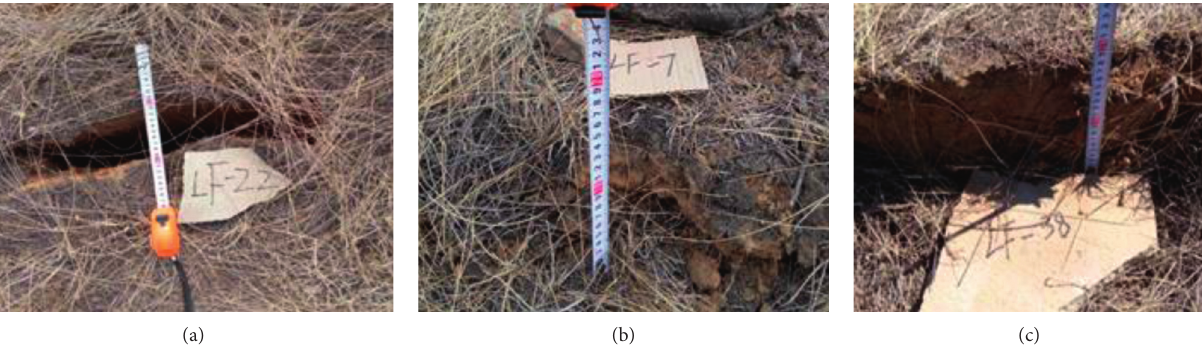
Figure 12: Classification of surface cracks in the working face. (a) Tensile cracks, (b) hysteretic extrusion crack, and (c) stepped cracks.